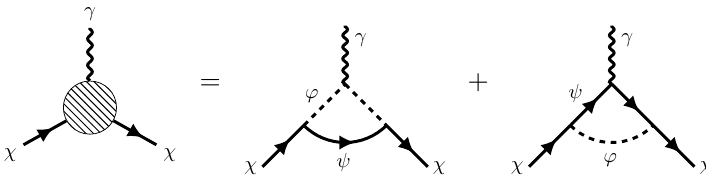
Figure 10 . Diagrams generating a interaction between dark matter and a photon at one loop.